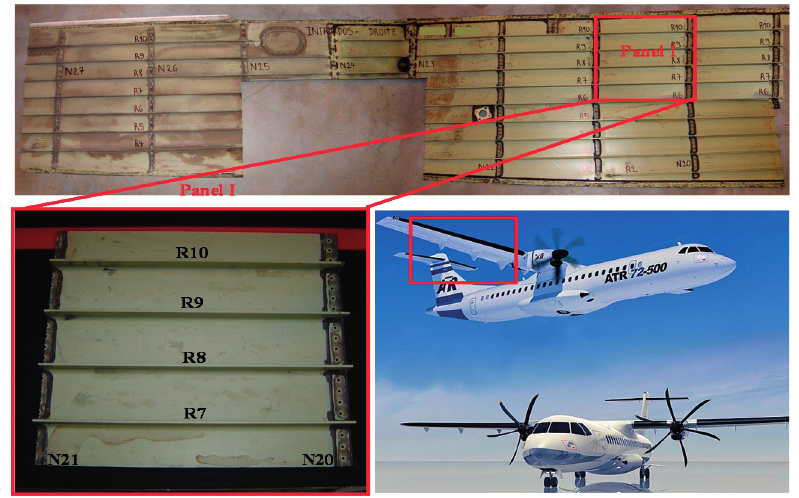
Figure 16. Extracted composite specimen from an ATR72 wing pannel.